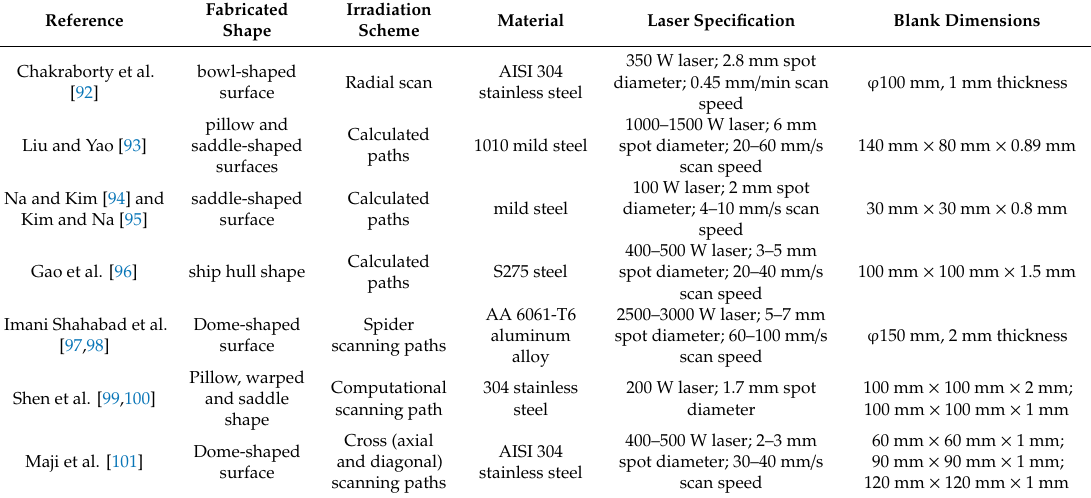
Table 2. Comparison of the irradiation scheme for laser forming of curved sheets